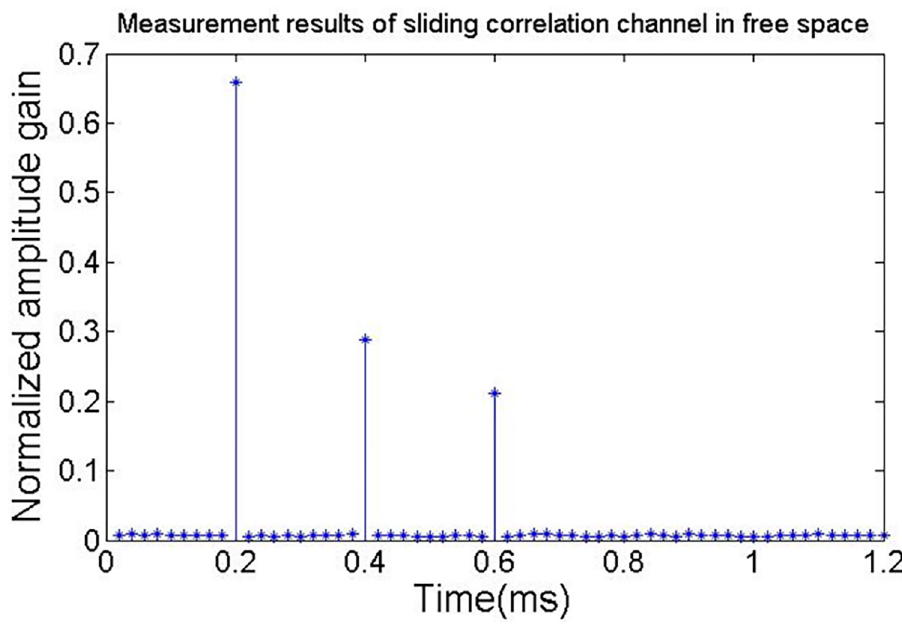
Fig 8. Channel impulse response.